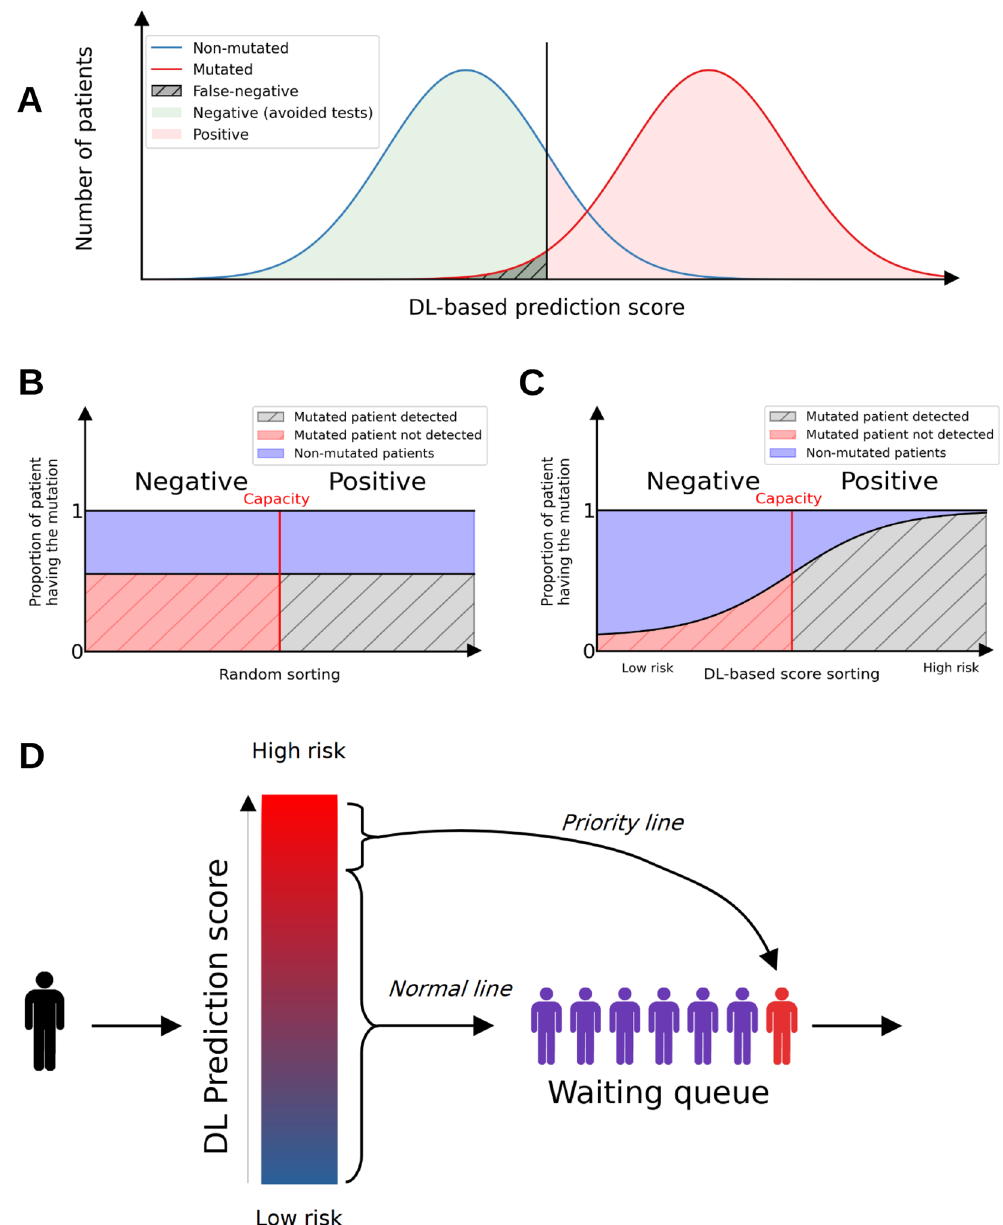
Figure 2. Diagnostic strategies of the deep learning triage pipeline. ( A ) Save-all strategy, red and blue gaussian curves are respectively the number of patients with and without a given mutation. The red zone corresponds to the positive patient for the DL-based diagnostic test and green zone the negative patient. The gray area is the type II error (false negative) taking the value of 5% in our different scenarii. ( B ) and ( C ) Fixed-capacity strategy respectively using the DL-based diagnostic test and using random test. The red vertical line is the limit capacity of DNA sequencing diagnostic tests, therefore all patients having a higher score than the limit capacity are diagnosed. The y-axis corresponds to the proportion of mutated patients for a given DL-based diagnostic score. The screeningDL-based strategy is expected to find more mutated patients than the random strategy using the same number of diagnostic tests. ( C ) – ( D ) Priority strategy, the blue-to-red gradient corresponds to the screening score, higher scores are in red. The top 5% or 10% patients are selected for priority diagnostic tests because they are very likely to be